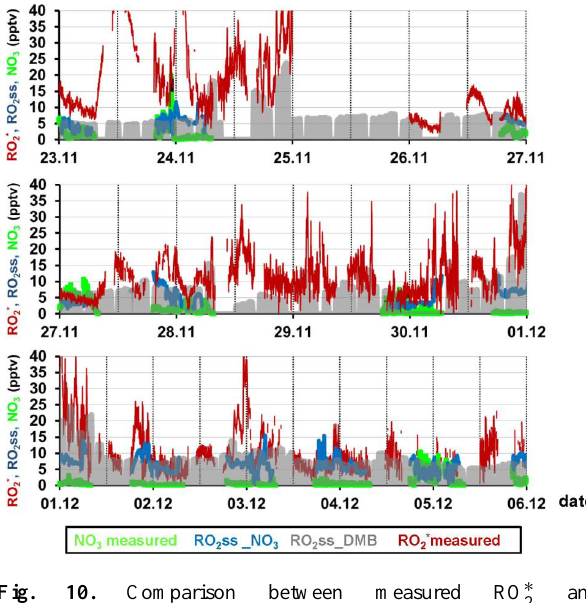
Fig. 10. Comparison between measured RO 2* and calculated RO 2nss produced from NO 3 (green) for k RO2+RO2 =7.1x 10 -12 cm 3 molec -1 s -1 . Shadow areas represent the calculated RO 2ss from ozonolysis of DMB: dimethylbutene. NO 3 mixing ratios are additionally plotted (green dots).